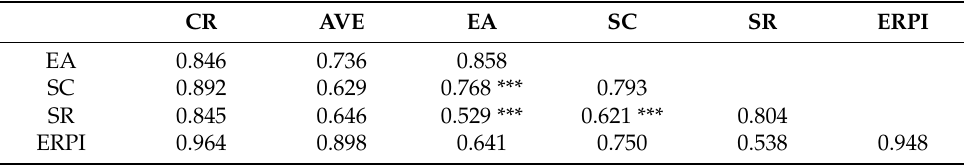
Table 5. Fornell and Lacker’s criteria for discriminant validity. CR AVE